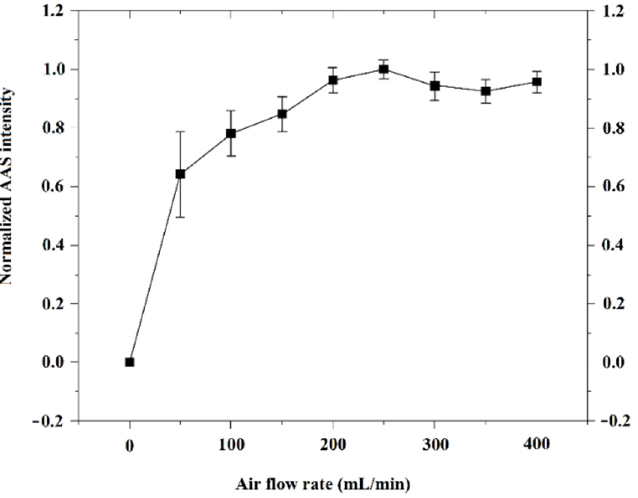
Figure 2. Effect of pre-vaporization temperature on Cd signal. The Cd signal intensity under 765 °C was set as 1, and the others were normalized with it. Solid line: N 2 /H 2 mixture atmosphere was employed; dotted line: N 2 /H 2 mixture atmosphere was invalid.